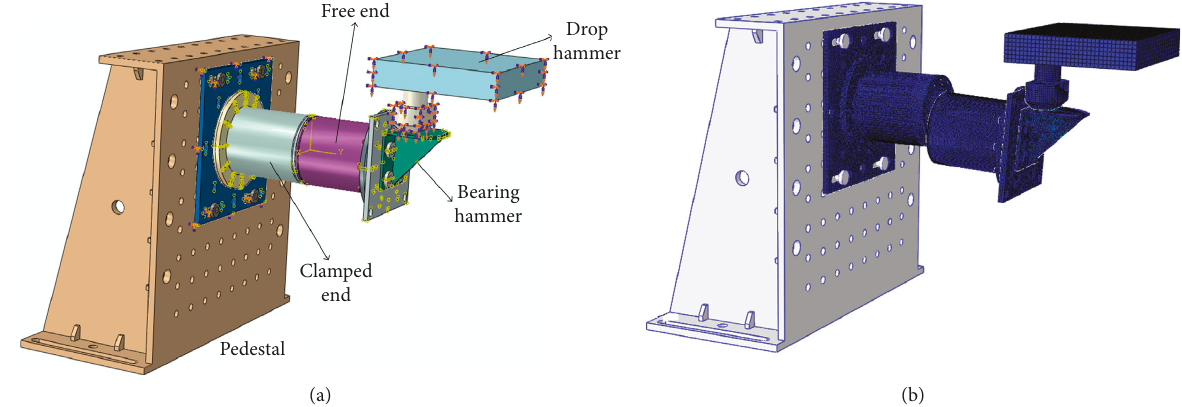
Figure 6: The finite element model. (a) Transverse impact experiment. (b) Calculation